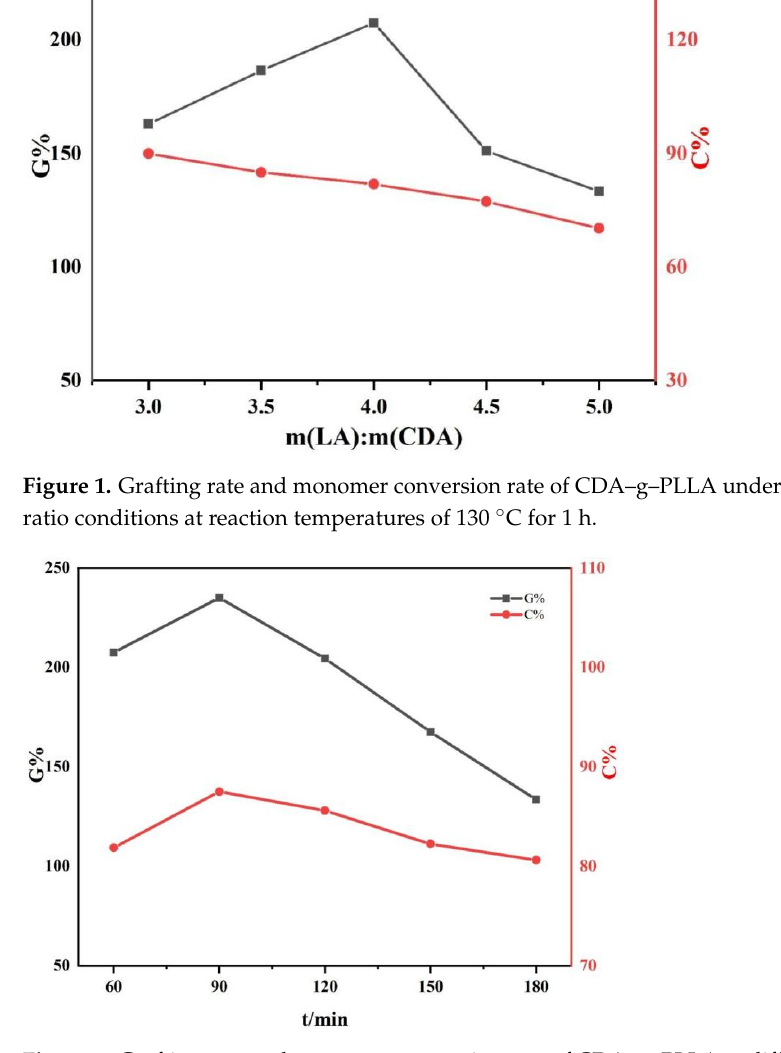
Figure 1. Grafting rate and monomer conversion rate of CDA − g − PLLA under different feeding mass ratio conditions at reaction temperatures of 130 °C for 1 h.